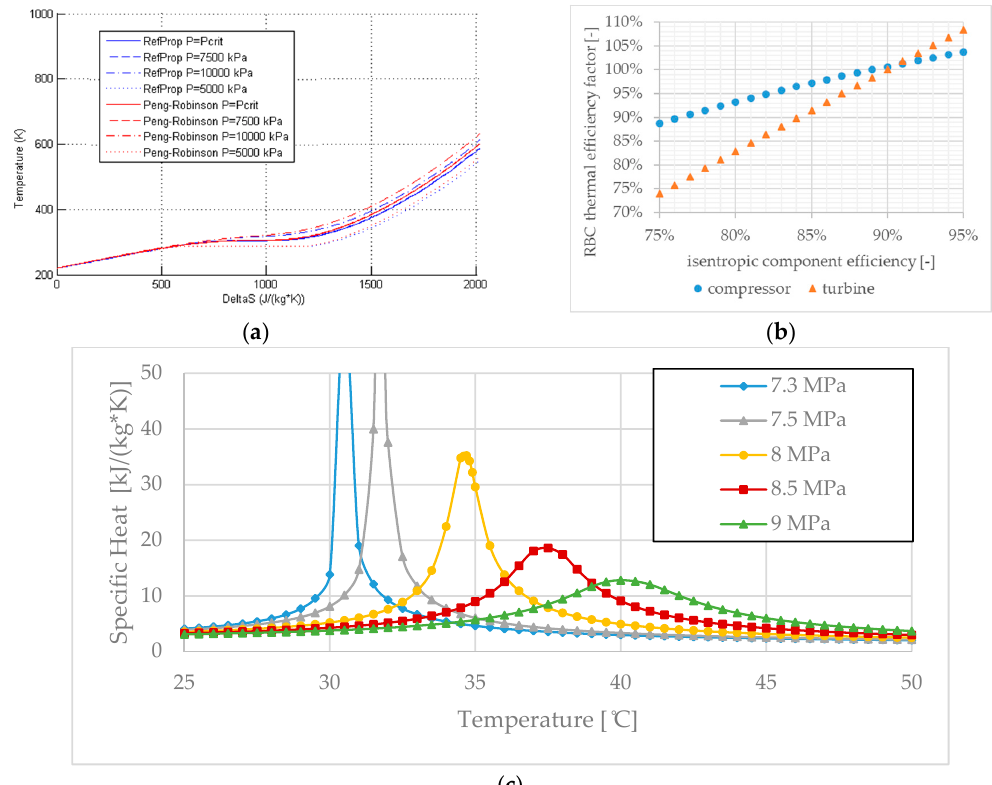
Figure 2. ( a ) Comparison of Peng-Robinson Equation of State (PREOS) [26,27] and Span & Wagner Equation of State (SWEOS) [28] near the critical point of S-CO 2 ; ( b ) sensitivity of RBC thermal efficiency to compressor and turbine isentropic efficiencies; and ( c ) specific heat variation of S-CO 2 near the critical point.